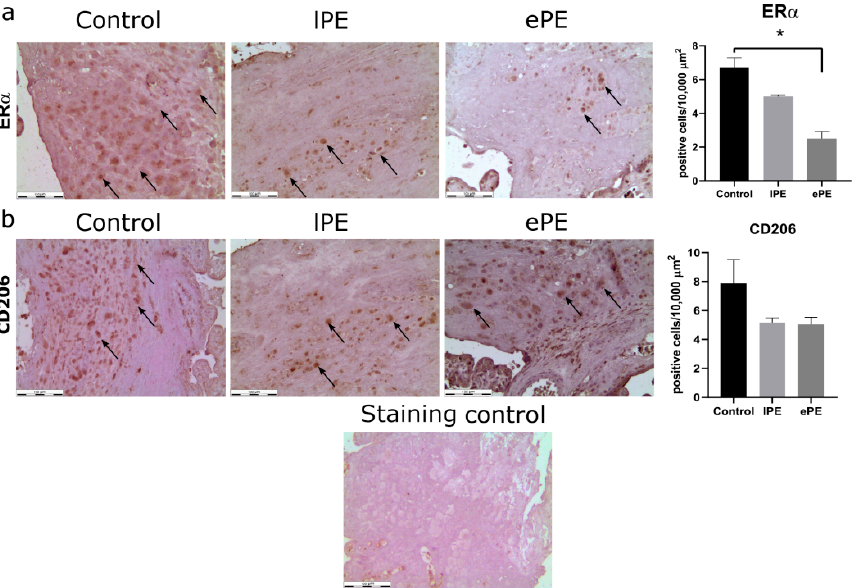
Figure 3. Immunohistochemical analysis of ER α - and CD206-positive cells in decidua basalis of lPE, ePE and the control placenta samples. The percentages of ER α - and CD206-positive cells per 10,000 µm 2 are indicated. Representative photos of sections stained with hematoxylin and anti-ER α ( a ) and anti-CD206 ( b ) antibodies (DAB, brown, indicated by black arrows). Magnification, ×200; bars, 100 µm. * p < 0.05 vs. control group according to Kruskal–Wallis non-parametric ANOVA with post hoc Dunn test.